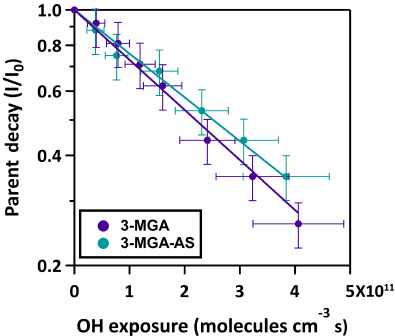
Figure 3. The normalized parent decay for the heterogeneous OH oxidation of 3-MGA and 3-MGA–AS particles at 85.0%RH. Note the logarithmic scale of the